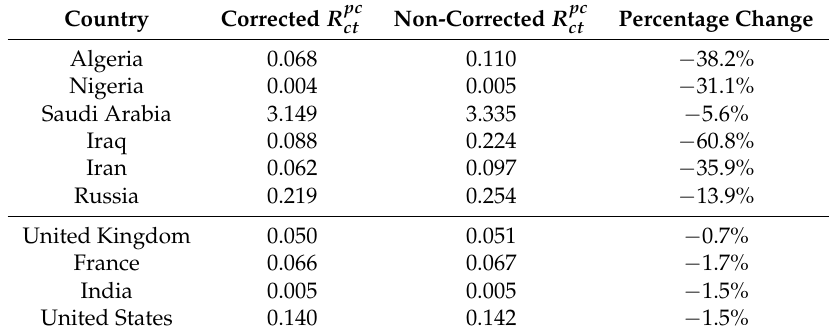
Table 2. Mean sum of light with and without correction in top flaring countries and in control